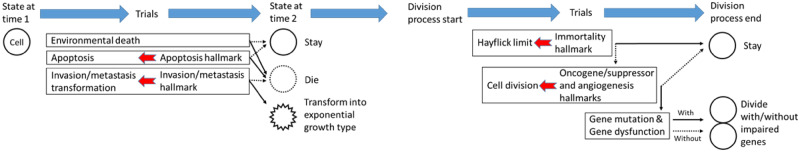
The simulation framework. A cell is put to a ‘trial’, through which the next state of the cell is probabilistically determined. For example, a cell may die in the ‘apoptosis’ trial based on the probability value for cell death by apoptosis. Hallmarks interfere with such trial probabilities when genes related to hallmarks are impaired by mutations. The variables of hallmarks represent probabilities or rates to modify trial probability values. For example, when a gene related to apoptosis is impaired, the hallmark variable of apoptosis decreases a probabilistic value in the apoptosis trial.